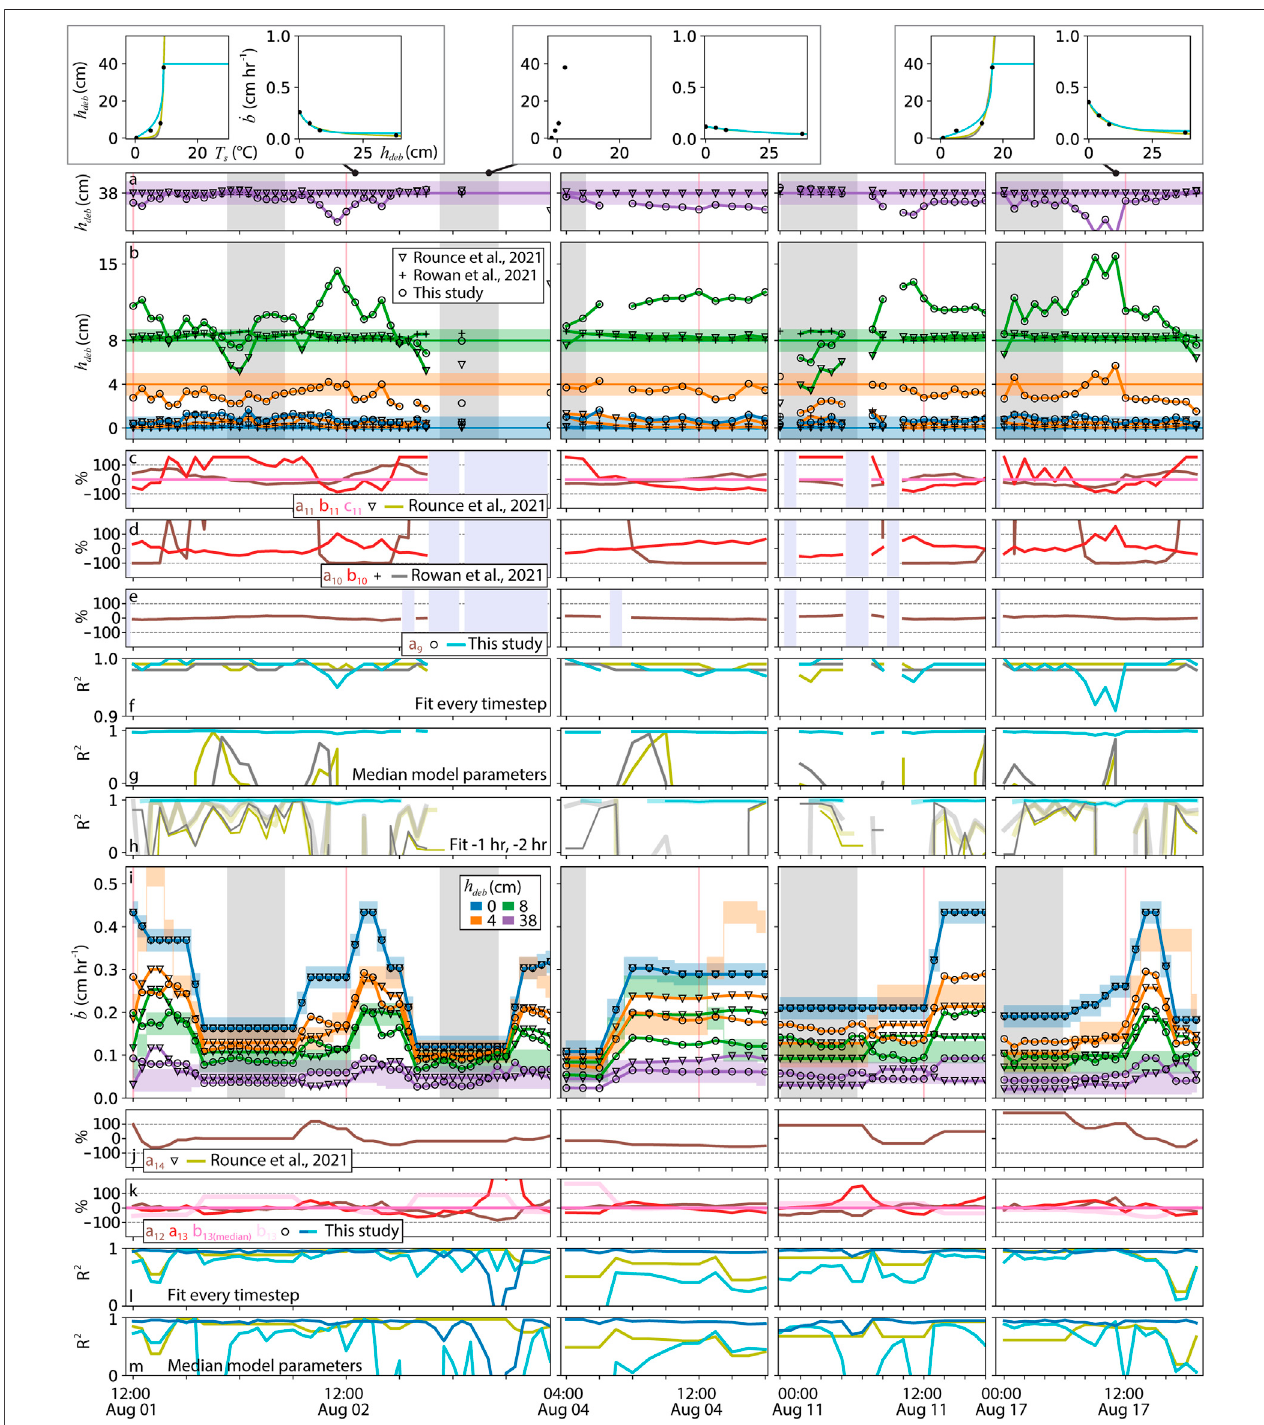
FIGURE5|(A,B) measured debristhickness, solid fl atlineswitha ± 1 cmerrorbuffer; andmodeleddebristhickness, forcedwith T s fromthermal camerasegment medians over the measured debris thicknesses. Model coef fi cients were calibrated for every timestep. A successful model would match the fl at line debris thickness of the same color for every timestep. Different models are denoted by shape at each timestep. Debris thickness colors are the same as (I) and Figures 3 , 4 , 6 : blue, bare glaciericeat Figure1 location(5);orange,4 cmdebristhickness(4);green,8 cmdebristhickness(2);andpurple,38 cmdebristhickness(1).Solidredverticallines shownoonofeachday,andgreyswathsshowthelocalnight[samein (I) ]. (C – E) Normalized[( x − median( x ))/median( x )]variabilityinmodelcoef fi cientscalibratedatevery timestepforthethreemethodsused.Legendgivesthemodelcoef fi cientname,subscriptwithequationnumber,andcolorcodedtotheplotofitsvariabilitythroughtime.